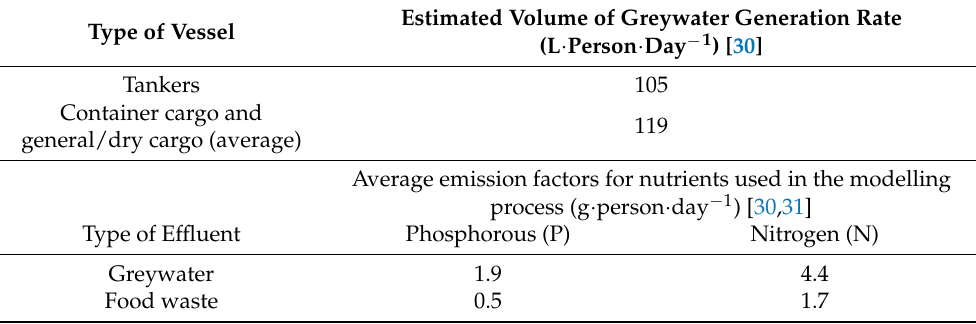
Table 5. Estimated volumes of generated greywater discharged from different ship types and assessed average factors for nutrients used in modelling in previous